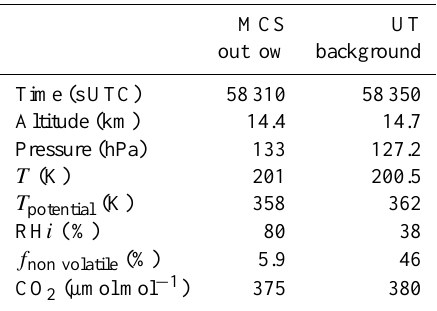
Table 3. Measurement details substantiating the air mass change before and after the NPF peak in Fig. 9 on 11 August